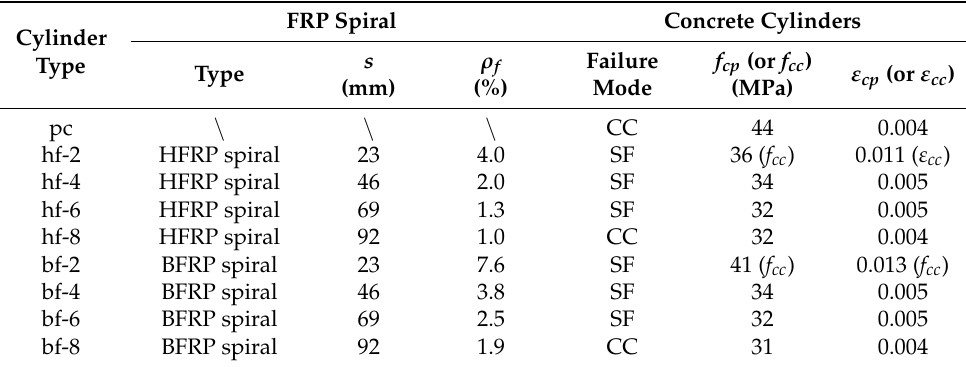
Table 1. Design details and test results of